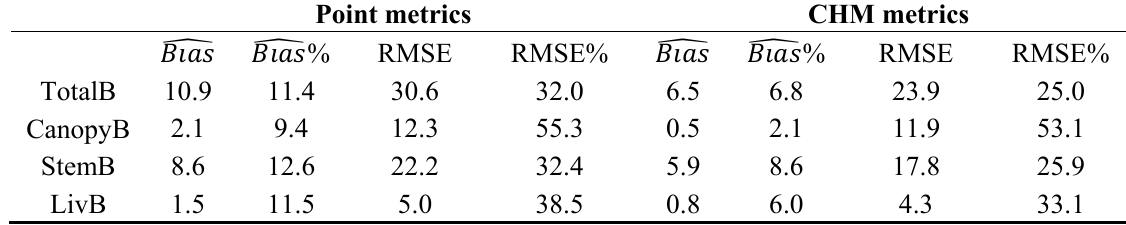
Table 3. Results calculated in trial 2: Training set = Leica-plots; Test set = Optech-plots. Point metrics CHM